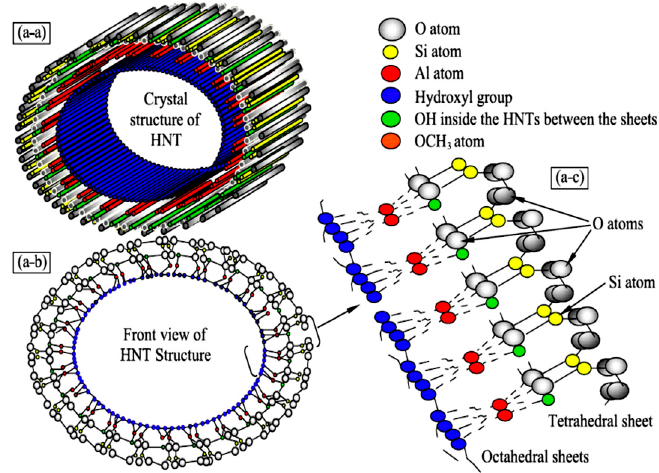
Figure 3. Crystalline structure of halloysite [53].